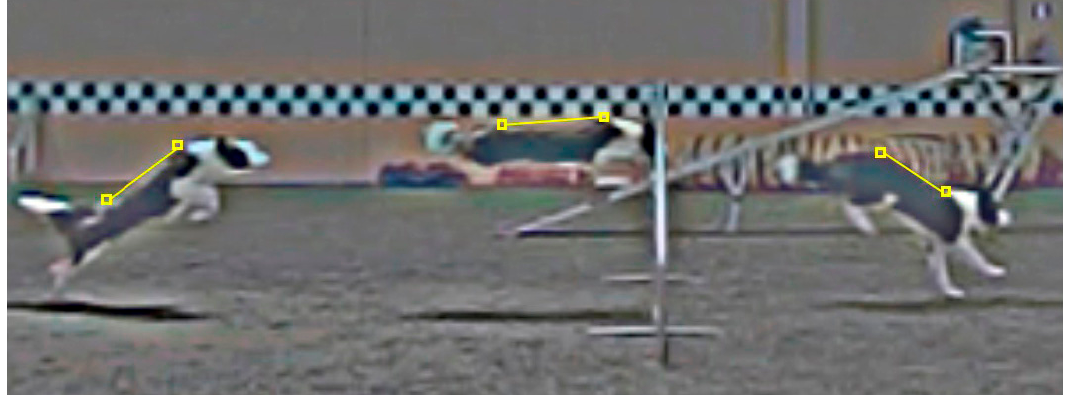
Figure 2. Virtual representation of take-off, maximal jump height, and landing sequences of an agility dog jumping over a 60-cm hurdle. Yellow marks and lines represent the withers, tuber sacrale, and back line.